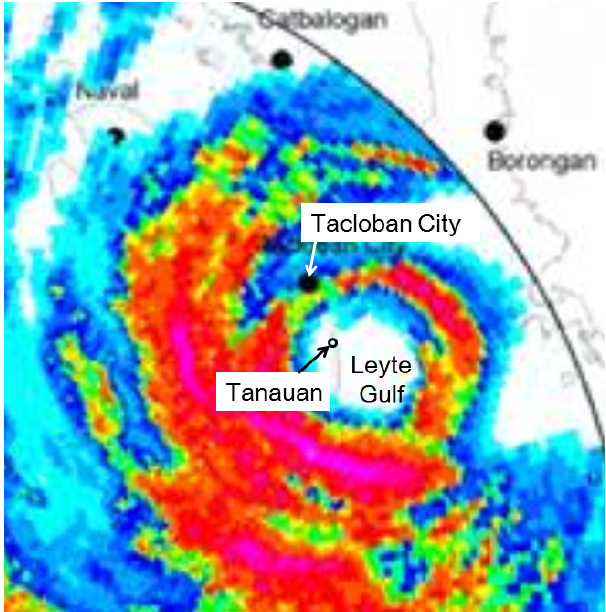
Figure 11. Rainfall intensity detected by the Doppler radar system on Cebu Island when Typhoon Haiyan passed the Leyte